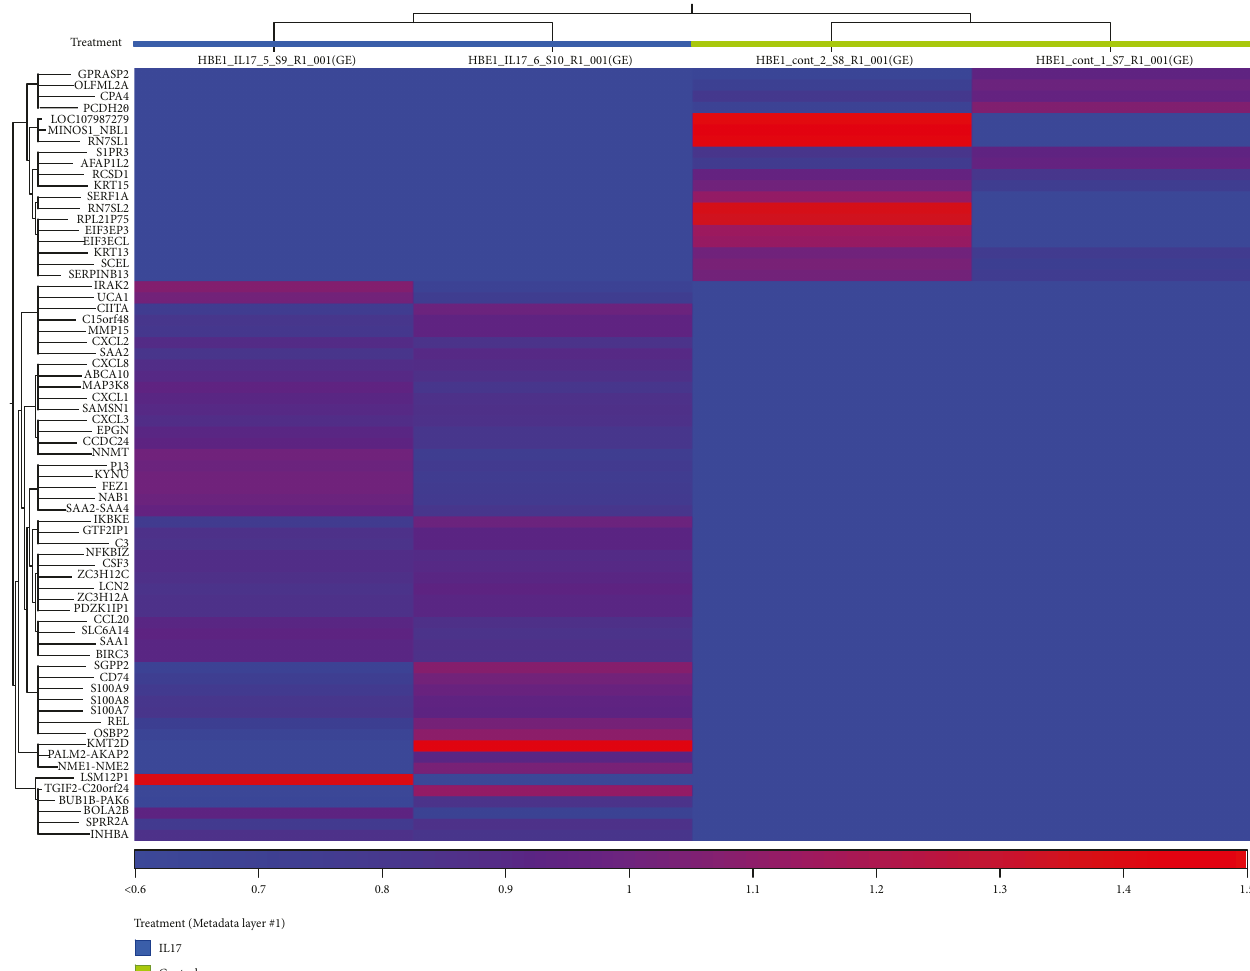
Figure 2: Heat map of genes regulated by IL-17A in HBE1 cells. Cells from the left two columns (under the blue bar) were treated with 100ng/ml h-IL-17A protein for 24 h while the right two columns (under the green bar) were treated with the control medium for 24